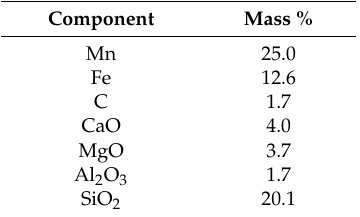
Table 1. Chemical analysis of the manganese